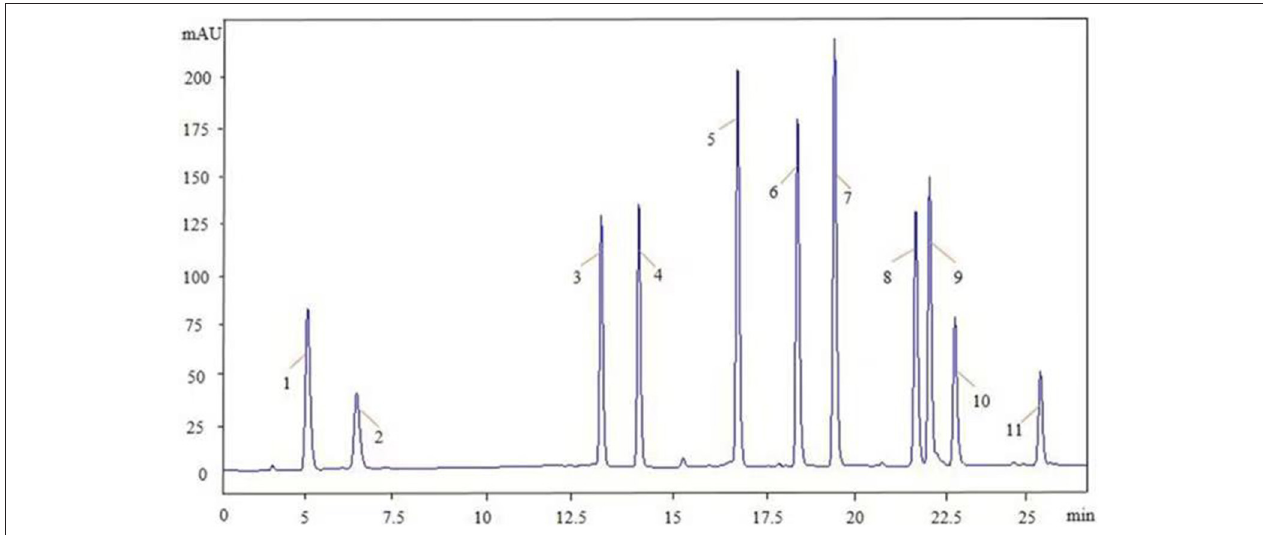
FIGURE 2 | The HPLC chromatogram of the 11 mixed standards. The peak numbers 1–11 represent the standard compounds 1–11 in Figure 1. HPLC, high-performance liquid chromatography.